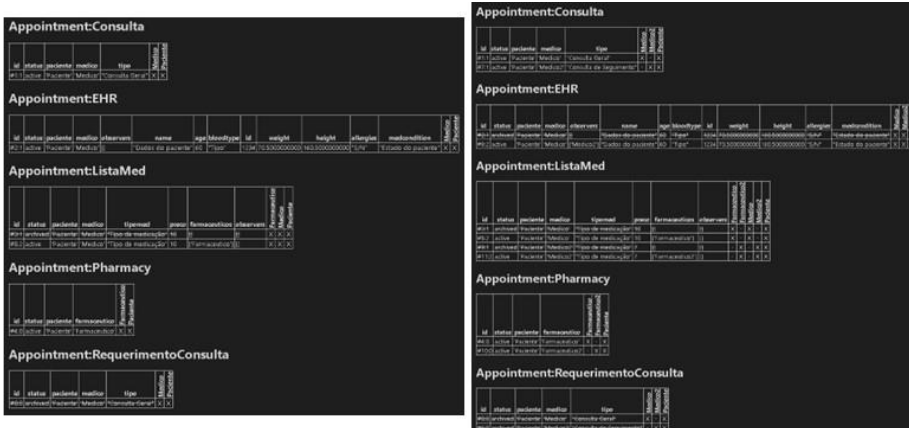
Figure 6. Application print screen for case 1 (left image) and case 2 (right image).